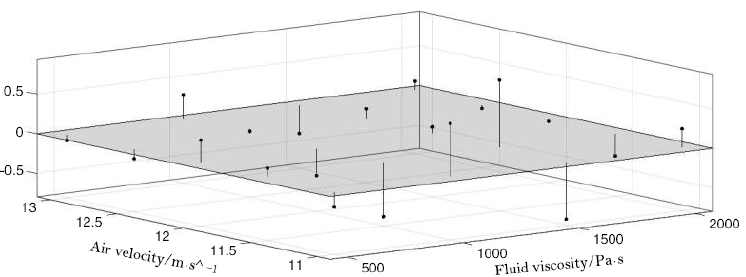
Figure 15. Calculated residuals for the relationship between gas jet velocity, dimethyl silicone oil viscosity and surface wave period.